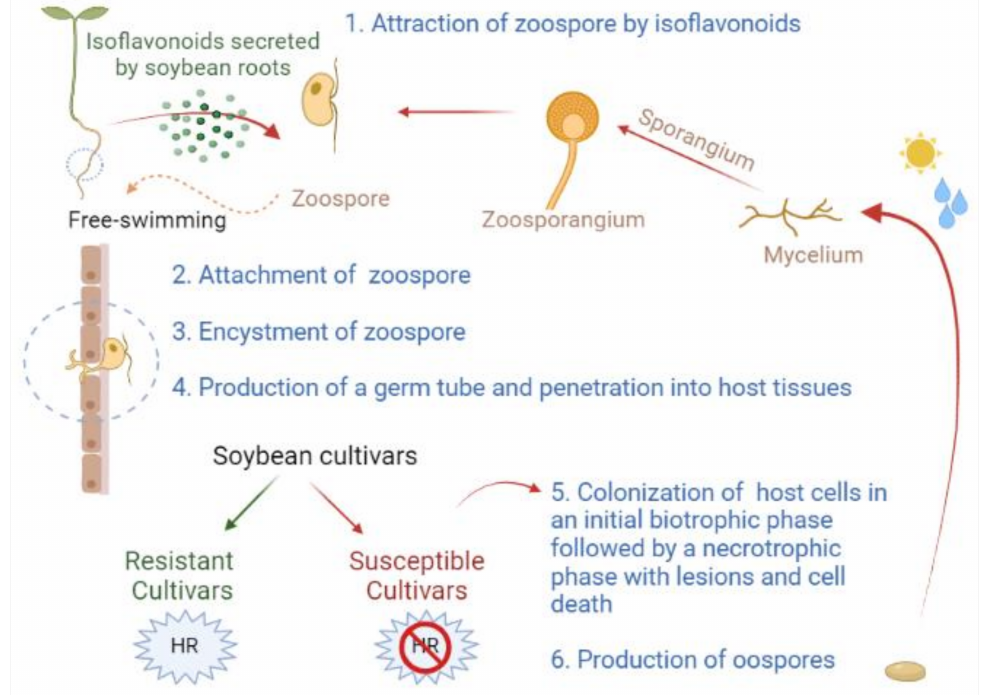
Figure 1. Process of P. sojae infection and response of soybean according to susceptible and resistant cultivars. The zoospores are attracted by root exudates (isoflavones daidzein and genistein), attach to the root surface and encyst before producing a germination tube entering the plant cells. If the host is a resistant cultivar, it induces hypersensitive reaction giving an incompatible interaction. Conversely, if the host is a susceptible cultivar, it triggers a wide array of biological processes following infection. The pathogen colonizes host cells in an initial biotrophic phase followed by a necrotrophic phase with necrotrophic lesions resulting in host cells death. Finally, under unfavorable conditions (low humidity and temperature) oospores are produced. These sexual spore can survive for a long time in the soil and plant debris. They can germinate and initiate a new disease cycle if the conditions are favorable for the disease development (high moisture and temperature around 25–30 ◦